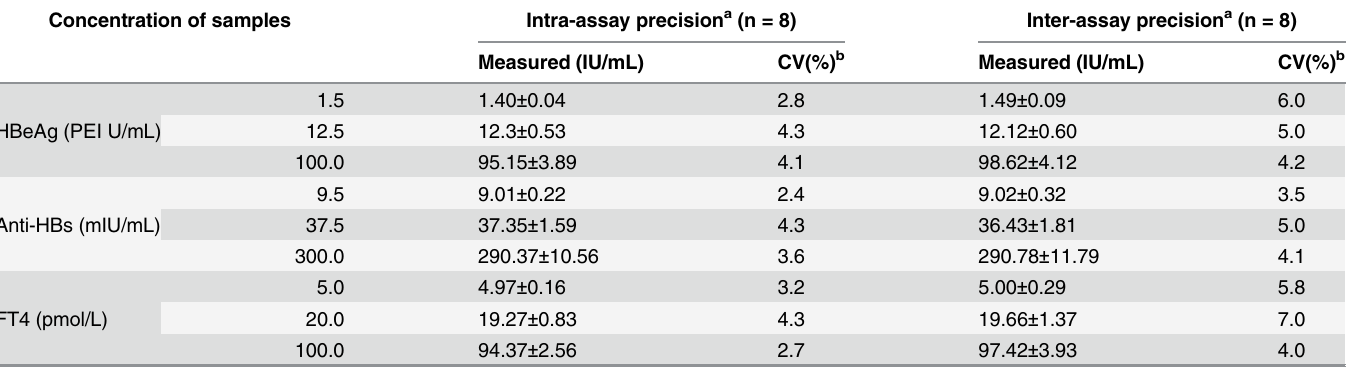
Table 3. Assay precision: intra-assay and inter-assay stability of the MMPs-TRFIA. Concentration of